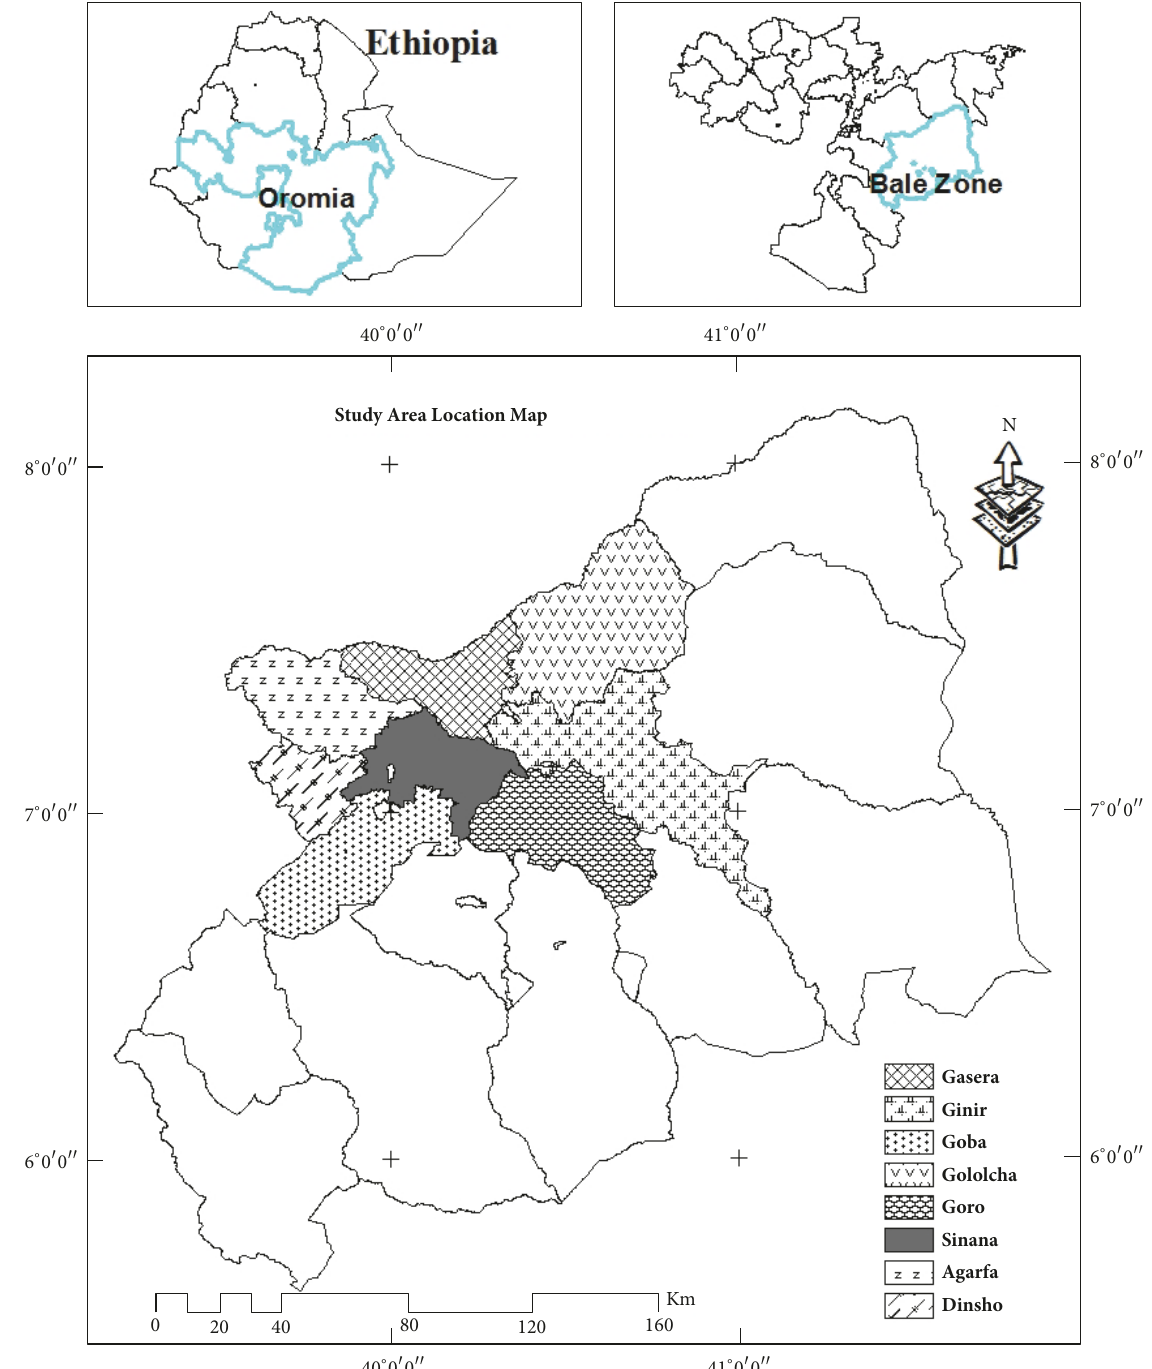
Figure 1: Map of Ethiopia and the Bale highlands showing the surveyed districts.